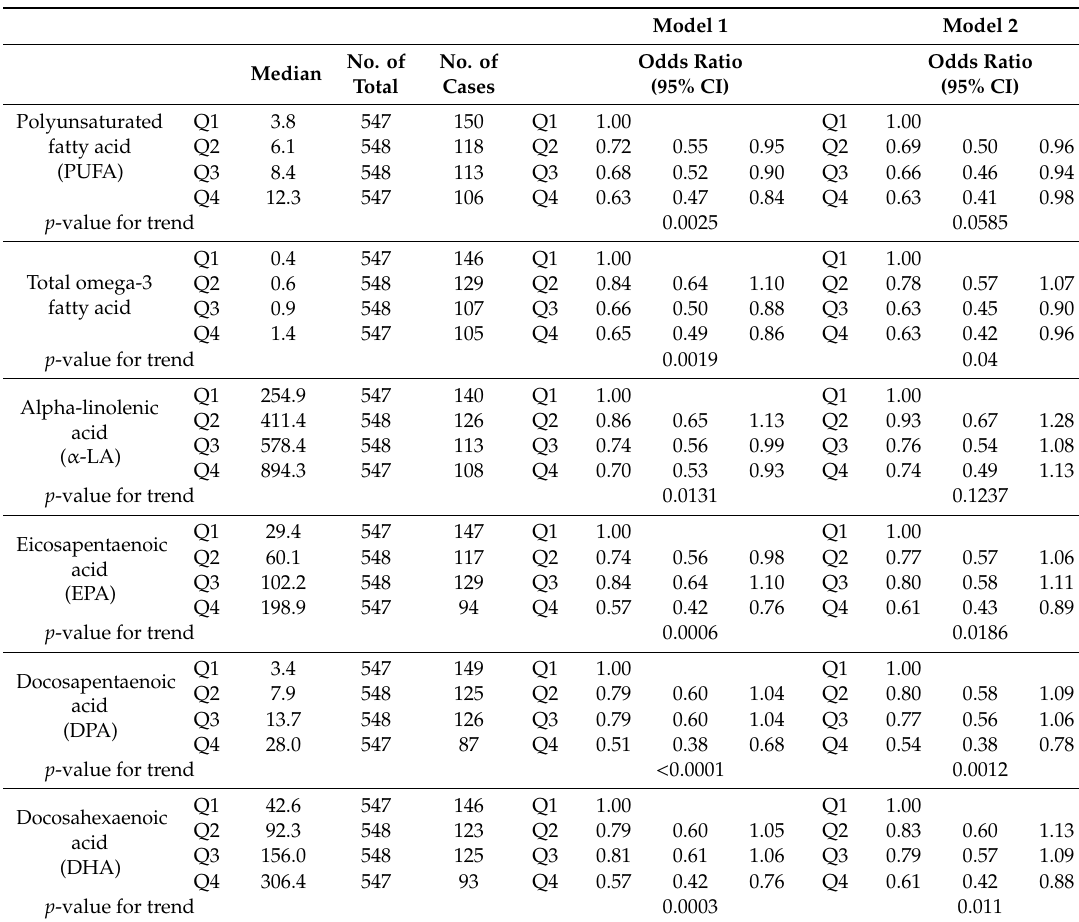
Table 3. Association between omega-3 fatty acid intake and the risk of depressive symptoms obtained by multivariate-adjusted logistic regression